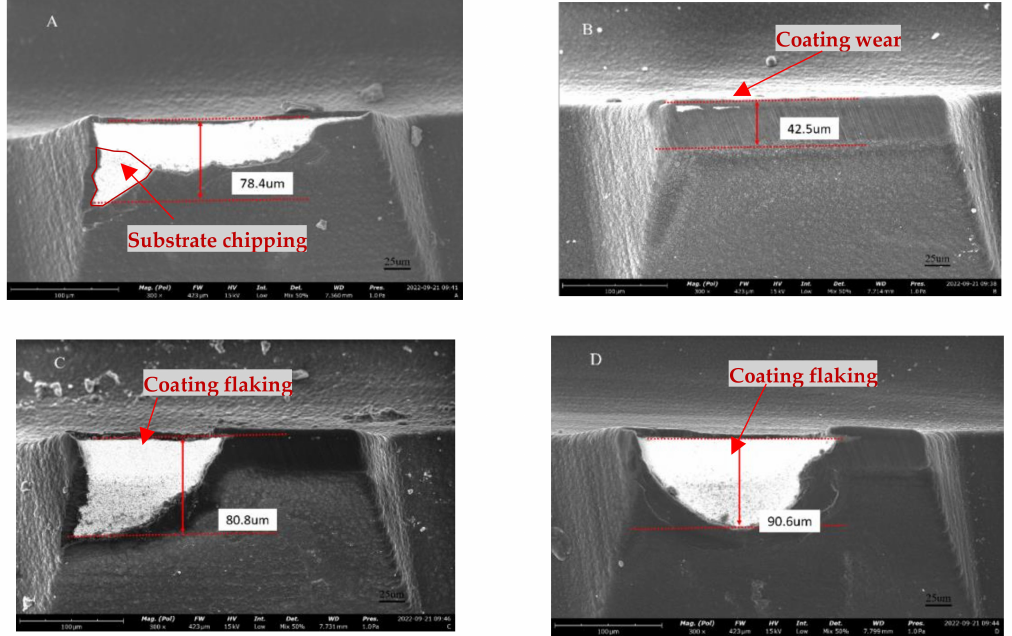
Figure 8. Wear morphology of the flank face of the milling tool with different pretreatment schemes. ( A ) Scheme A (Cutting length L = 119m); ( B ) Scheme B (Cutting length L = 198m); ( C ) Scheme C (Cutting length L = 158m); ( D ) Scheme D (Cutting length L =